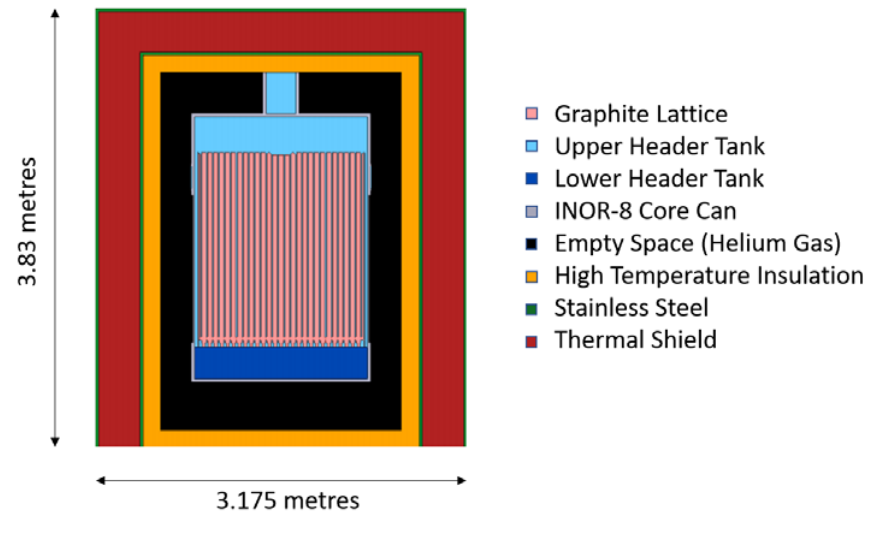
Figure 3: WIMS benchmark model, adapted from